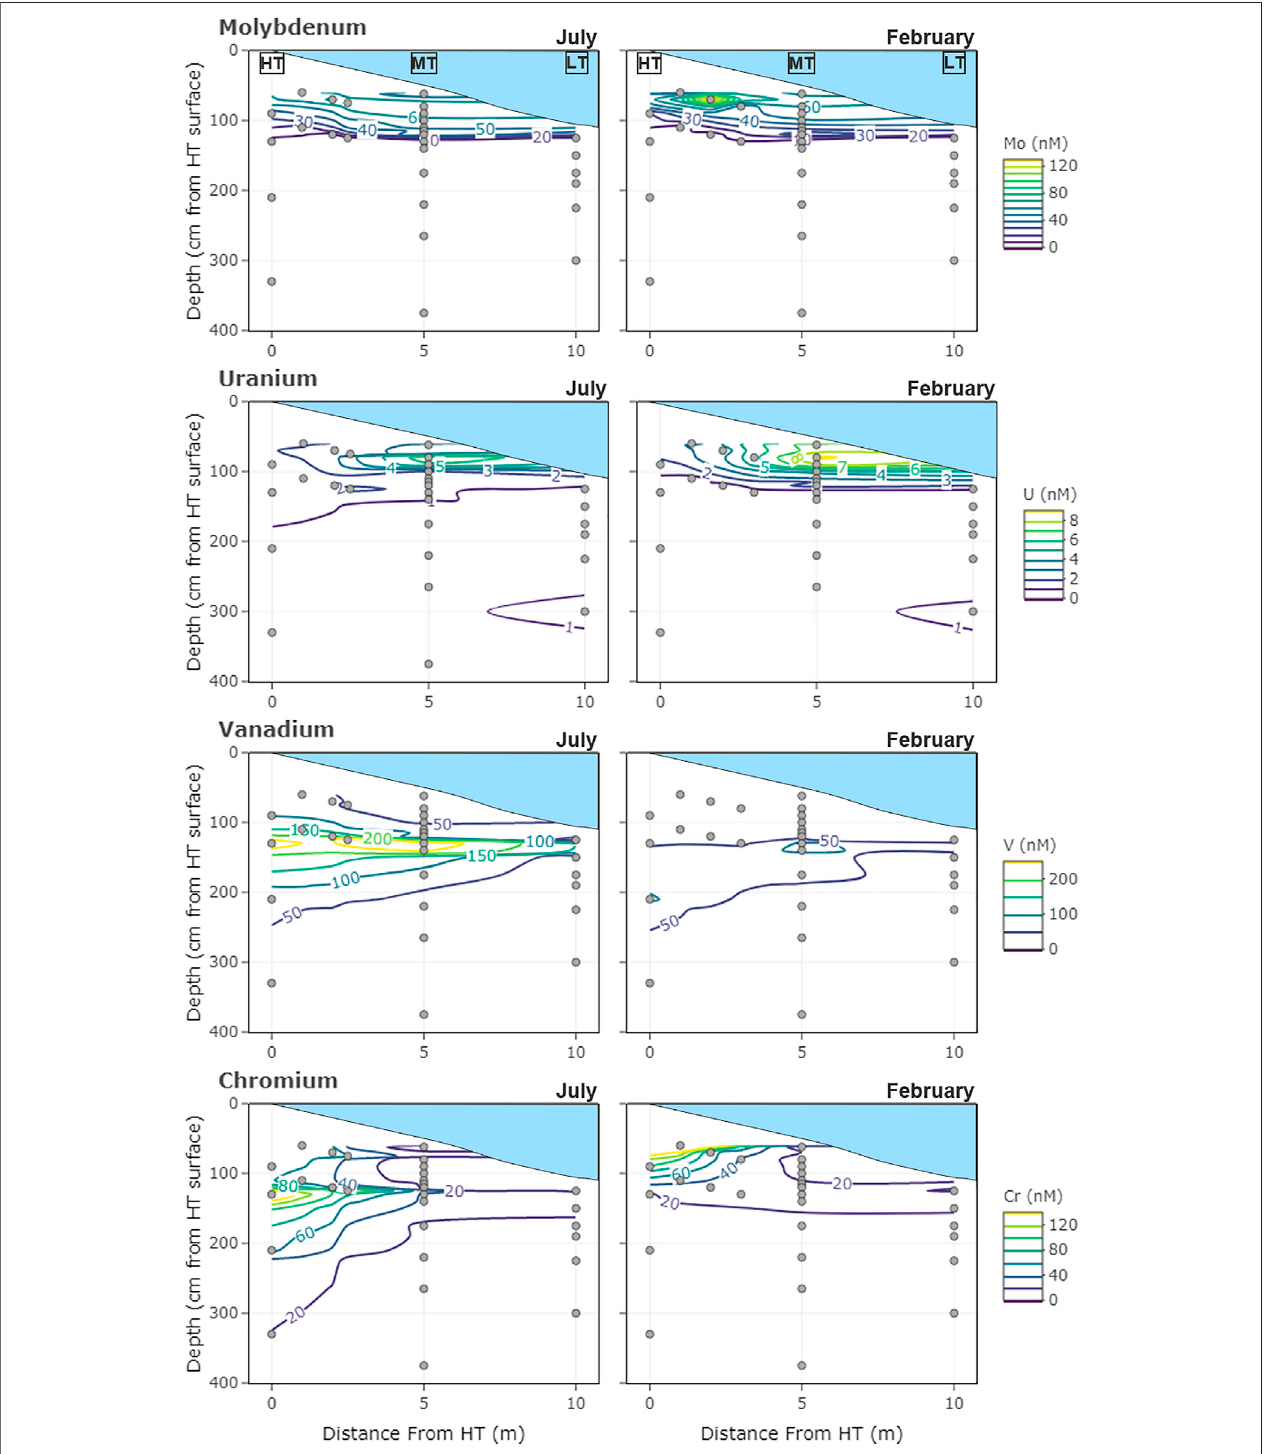
FIGURE 1 | Sampling locations of the subterranean estuary transect and concentrations of dissolved redox-sensitive metals (A) Mo (B) U (C) V, and (D) Cr measured in July 2014 and February 2015. Depth pro fi les were located at the spring high tide (HT), mid-tide (MT), and just below low tide (LT) water levels. Depths are measured relative to the high tide sediment surface (0